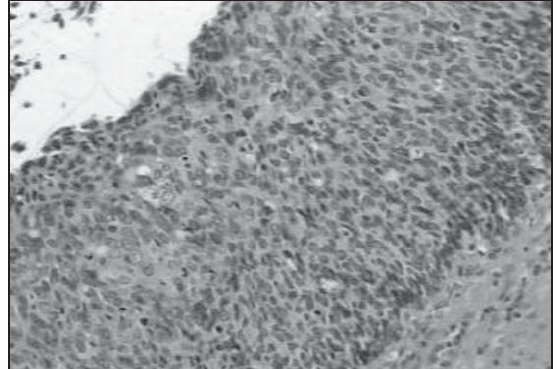
Figura 3 – Lesão intra-epitelial escamosa encontrada no epitélio de superfície tumoral. Perda de polaridade, maturação insufi ciente e presença de atipias em toda a espessura epitelial (H-E, 100x)